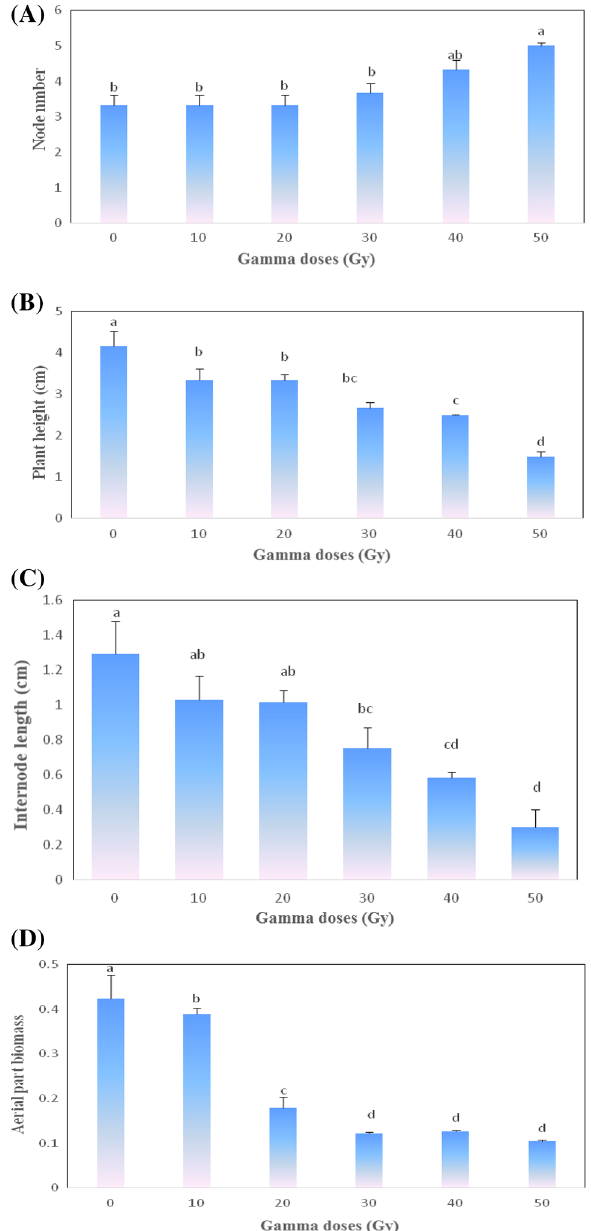
Figure 2. The effect of different gamma irradiation doses on shoot morphometric traits (nod number, panel A ; plant height, panel B ; internode length, panel C , aerial part biomass, panel D ) of ‘Yaghouti’ grape ( Vitis vinifera L.) cultivar. The means with same Duncan’s multiple range test letters in each column are not statistically significant ( P ≤ 0.01). Data are average of four replications ±